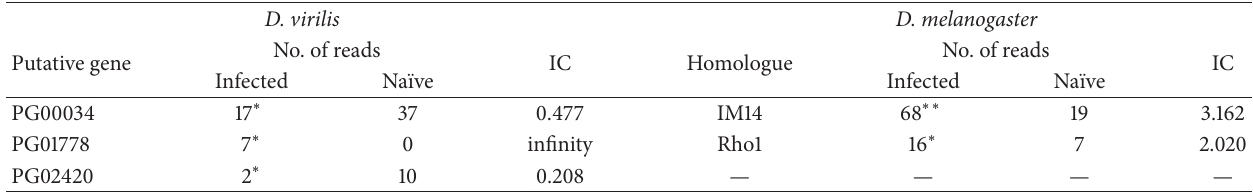
Figure4:Distributionofsequencelength(bp)ofcontigsconstructedfromthepyrosequencingreadsof D.virilis thatdidnothitanyannotated genes. Table 5: Number of reads and induction coefficient (IC) for putative immune-related genes in D. virilis and their homologues in D.